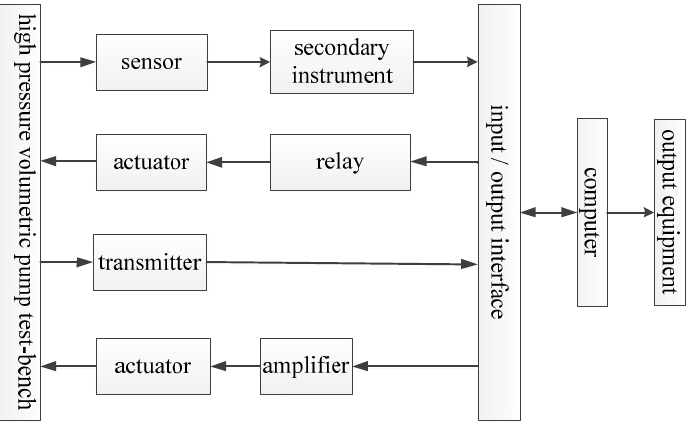
Figure 16. Overall design principle of test system.